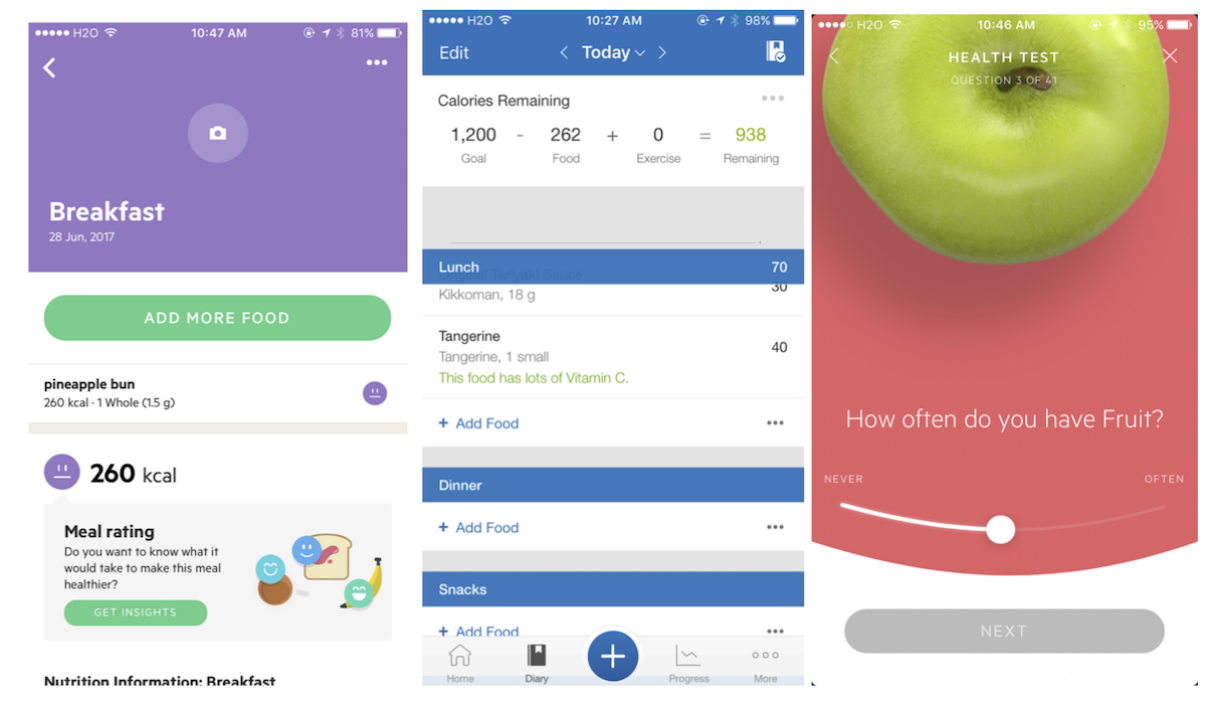
Figure 4. Meal rating feature with emojis in LifeSum (left), feedbacks on nutrient content for food items in MyFitnessPal (center), and Health test in LifeSum